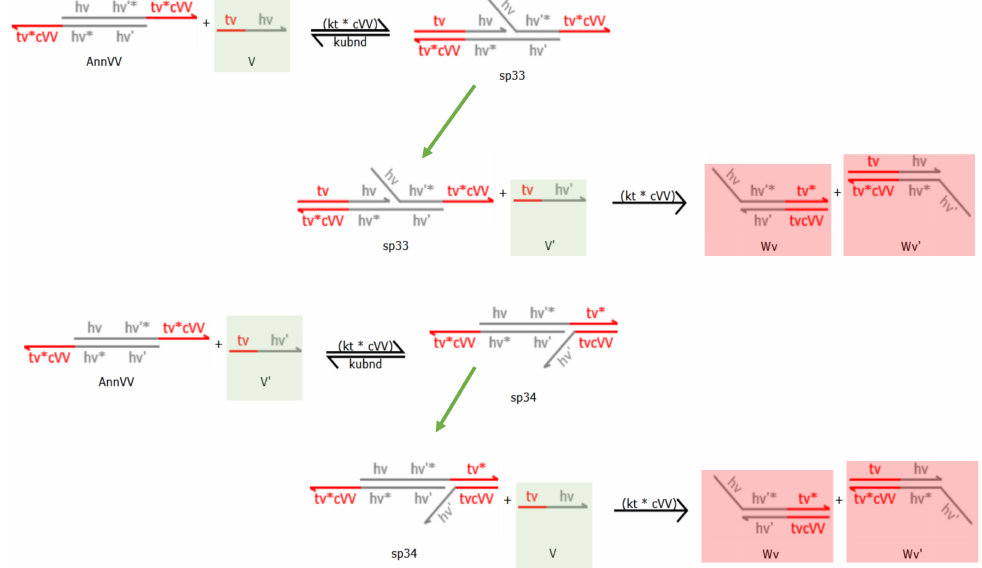
Figure 9. An example of a set of DSD reactions in which their dynamics are equivalent to an annihilation reaction generated in Visual DSD utilising the cooperative hybridisation approach following